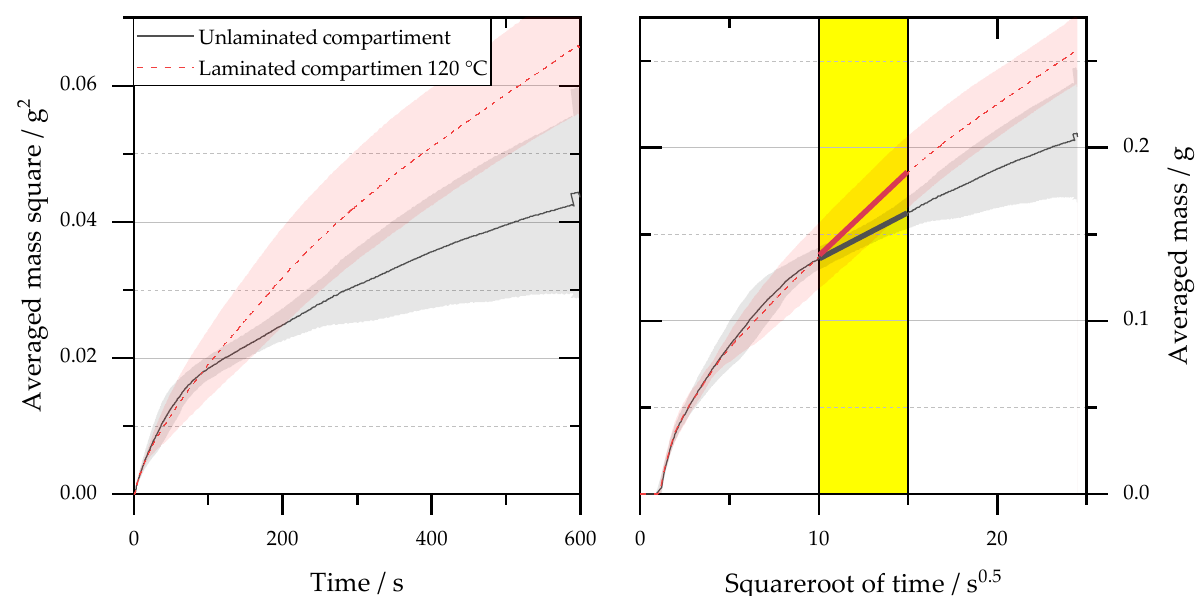
Figure A1. Results of gravimetric measurement of the anode separator measurement series (iv) to (v). Smoothed measure- ment data of the tensiometer measurement ( left ) and transformed measurement data with an evaluation range of 10 to 15 s 0.5 ( right ).